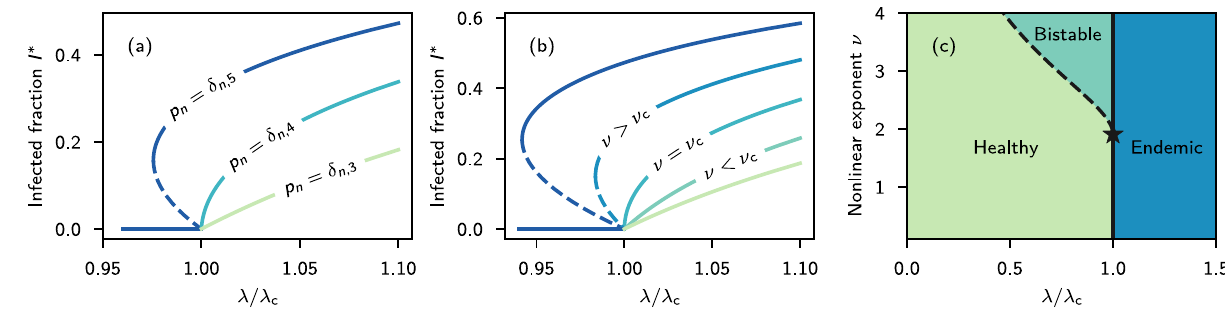
; δ n ; n 0 Þ . The infection 0